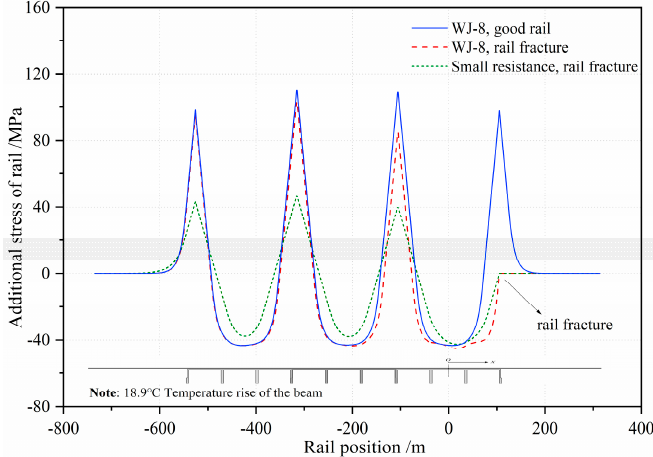
Figure 14. Additional stresses of the rail before and after rail fracture.